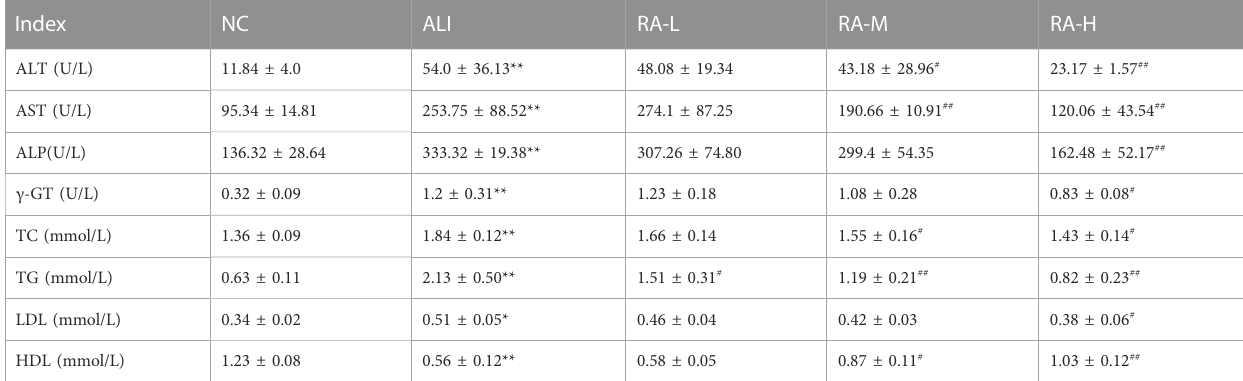
TABLE 2 The effects of rhubarb anthraquinone on serum biochemical indices in rats with acute liver injury (Mean ± s ). Index